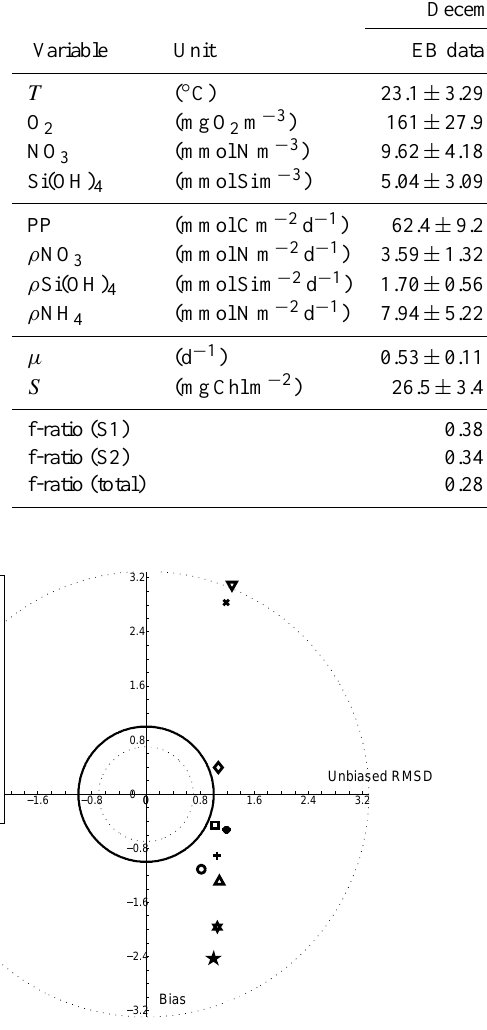
Fig. 3. Target diagram of PP and nutrient uptake rates in the EEP during 2004–2005. Diagram shows the normalized B and RMSD cp (unbiased RMSD) for the model PP, ρ NO 3 , ρ Si(OH) 4 , ρ NH 4 and satellite VGPM (Vertically Generalized Production Model) PP es- timates relative to the EB observations from December 2004 and September 2005. Concentric circles represent RMSD tot